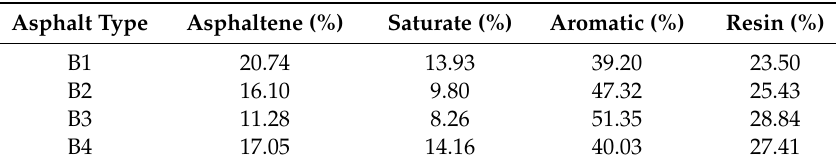
Table 2. Test results of four-component for matrix